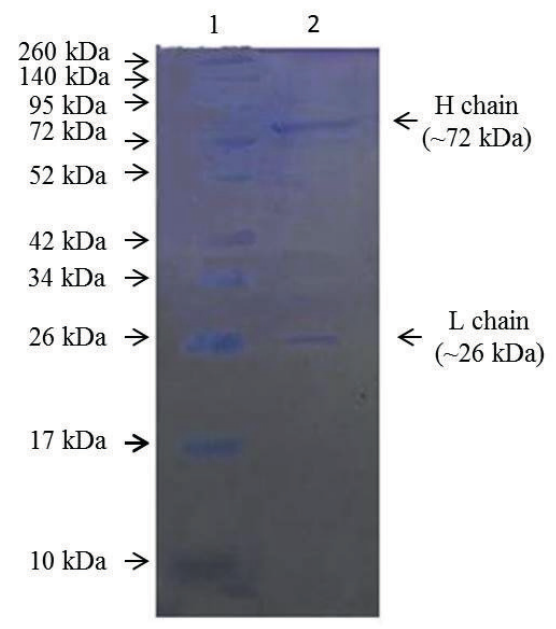
Figure 1 - SDS-PAGE of purified pacu ( Piaractus mesopo- tamicus ) IgM. Molecular weight marker (lane 1) and purified pacu IgM (lane 2).